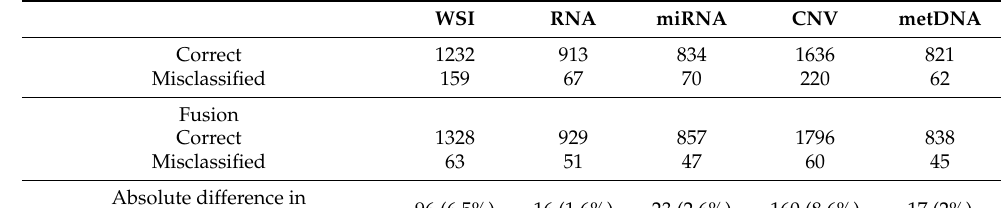
Figure 2. ROC curves for the fusion and individual models over all available samples for each modality. ( a ) ROC curve for LUAD class. ( b ) ROC curve for control class. ( c ) ROC curve for LUSC class. Table 5. Correct and misclassified samples over the whole dataset for each data type and the fusion model using all modalities. RNA, CNV, and metDNA stand for RNA-Seq, copy number variation, and DNA methylation, respectively.